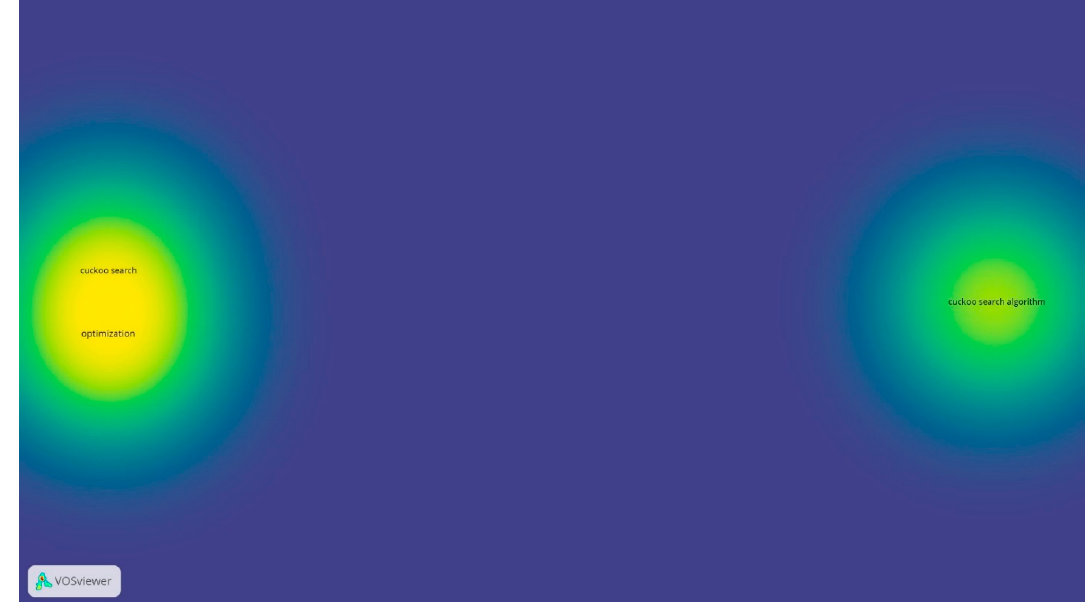
Figure 13. Total cluster obtained with the search “optimization fuzzy clustering with cuckoo search optimization” from VOSviewer.